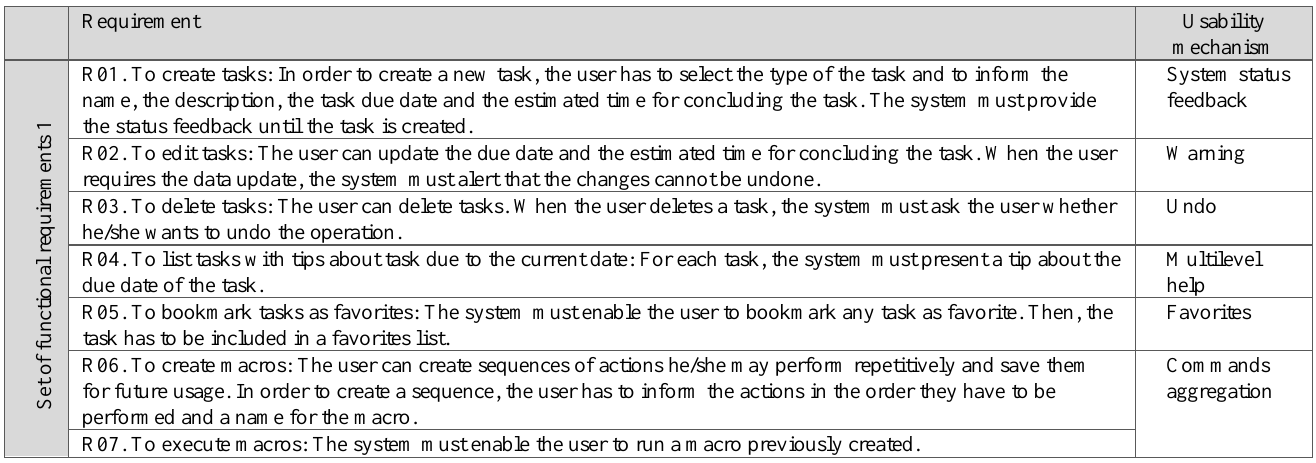
TABLE II. F UNCTIONAL REQUIREMENTS AND USABILITY MECHANISMS DESCRIBED IN THE SCENARIOS FOR THE MODELING TASK .